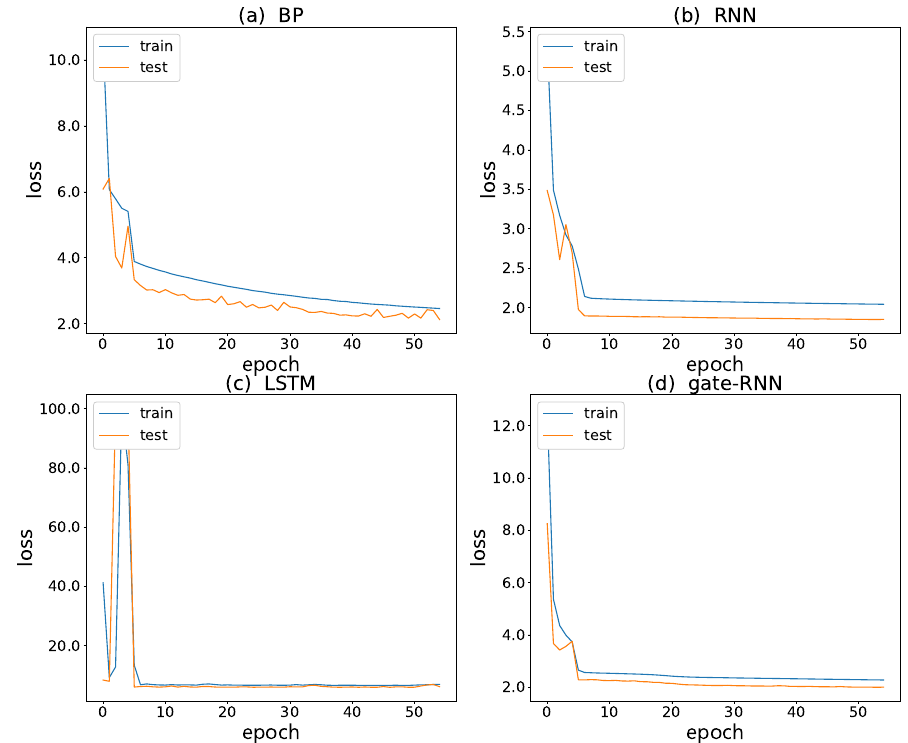
Figure 14. Neural networks’ losses on the train and test datasets for 30-min time scales: ( a ) loss of BPNN; ( b ) loss of RNN; ( c ) loss of LSTM; and ( d ) loss of gate-RNN. The blue line is the train loss curve and the orange line is the test loss